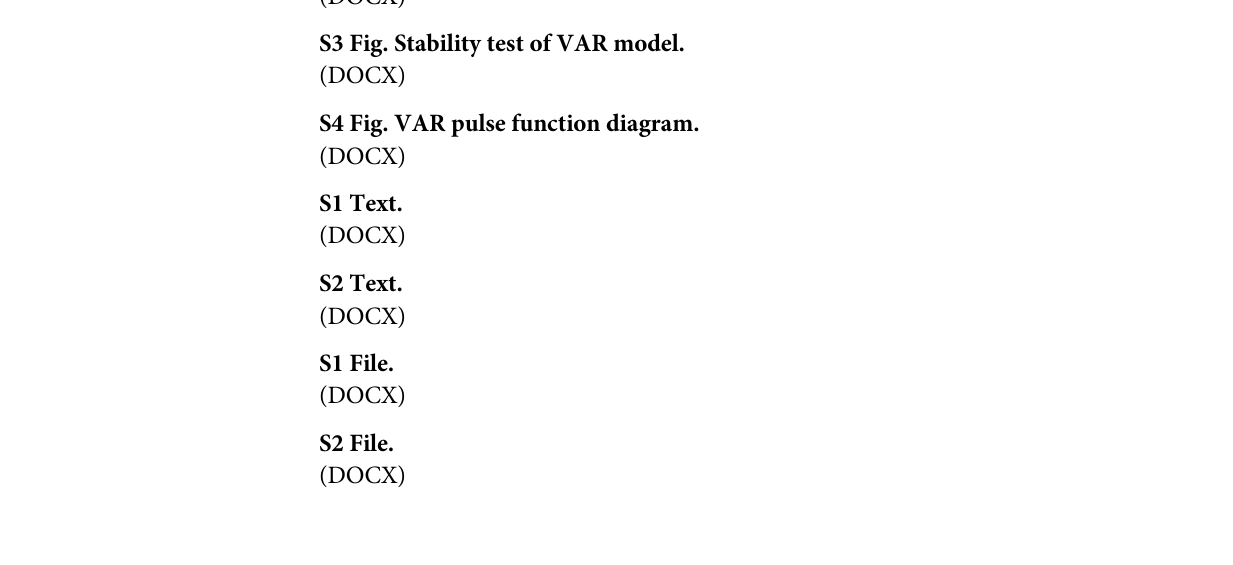
S3 Fig. Stability test of VAR model. S4 Fig. VAR pulse function